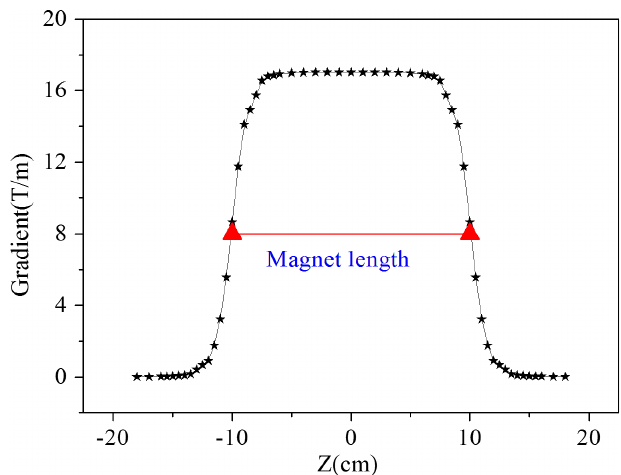
FIG. 8. Variation of the field gradient in T/m along the length of the magnet.